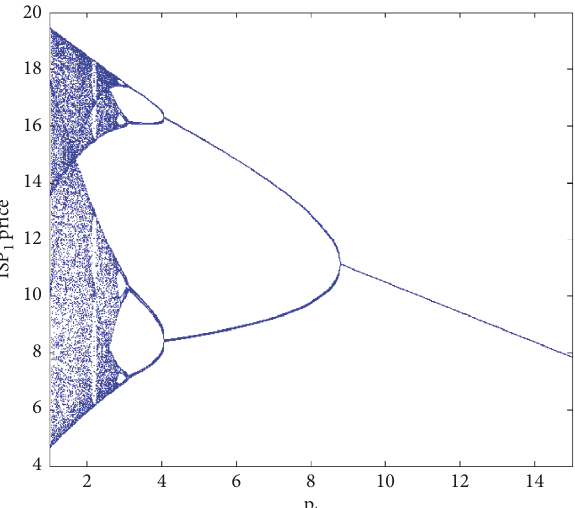
with respect to α . 2